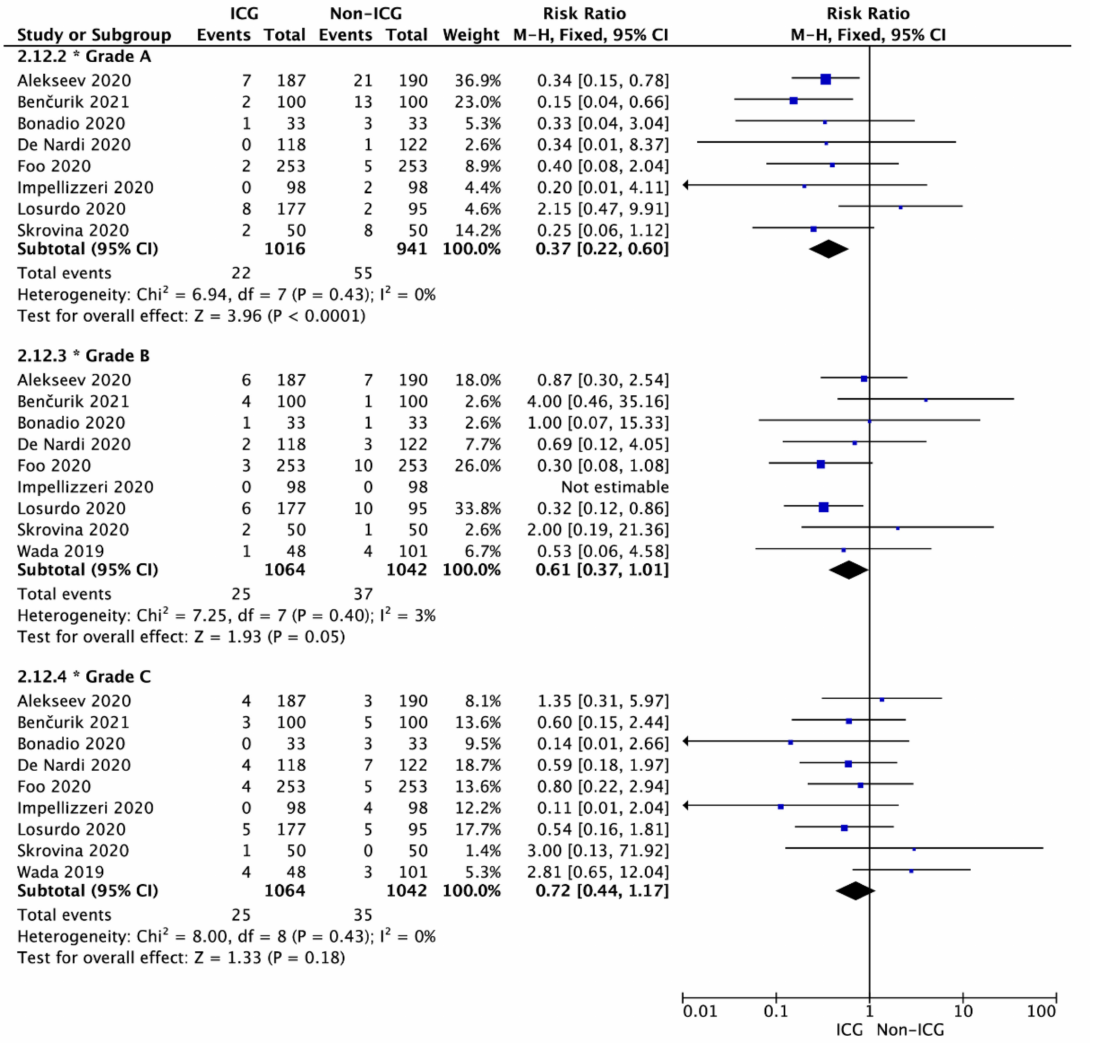
Figure 3. Forest plot of anastomotic leak occurrence in the ICG vs. non-ICG groups with sub-analysis with respect to the anastomotic leak grade. The square centers represent the weighted risk ratios for individual trials, and the corresponding horizontal lines stand for the 95% CI. The diamonds represent pooled results. Legend: CI = confidence interval; ICG = indocyanine